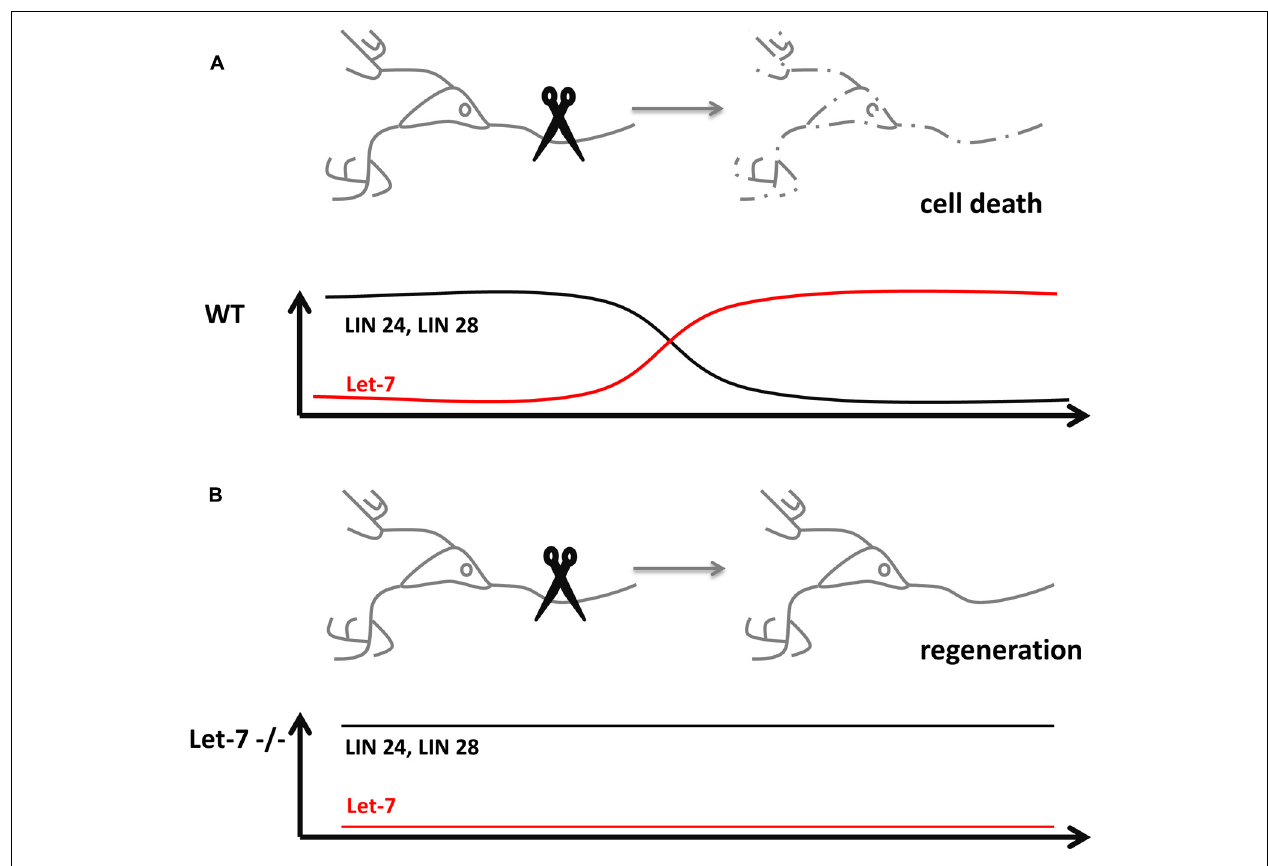
FIGURE 1 | microRNAs influence neuronal regeneration. (A) Severing of an axon usually causes cell death in wildtype neurons (dashed lines), which lost its potential for regeneration through the downregulation of the